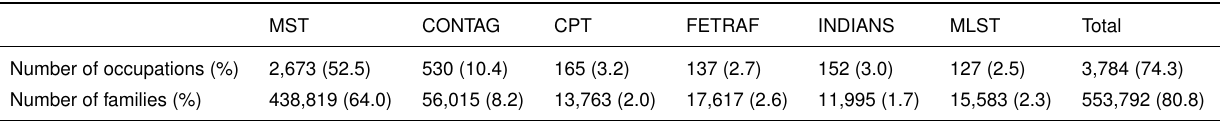
Table 1. Different manifestations aimed at attaining visibility to the struggle for land,